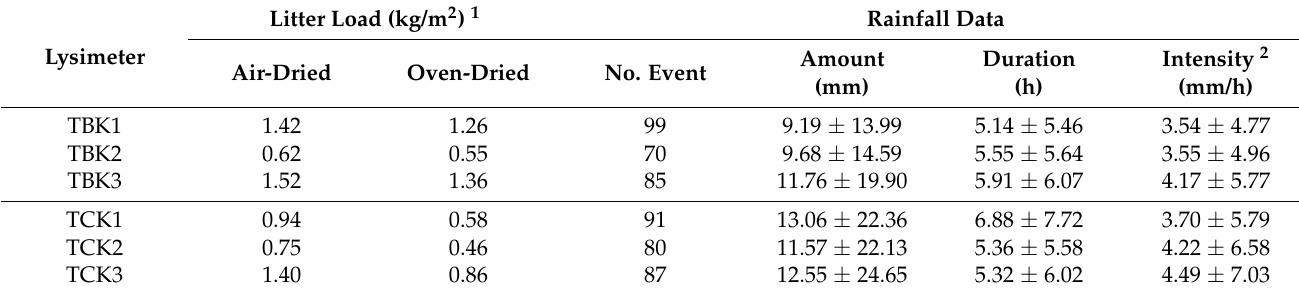
Table 2. Characteristics of rainfall and leaf load at each lysimeter